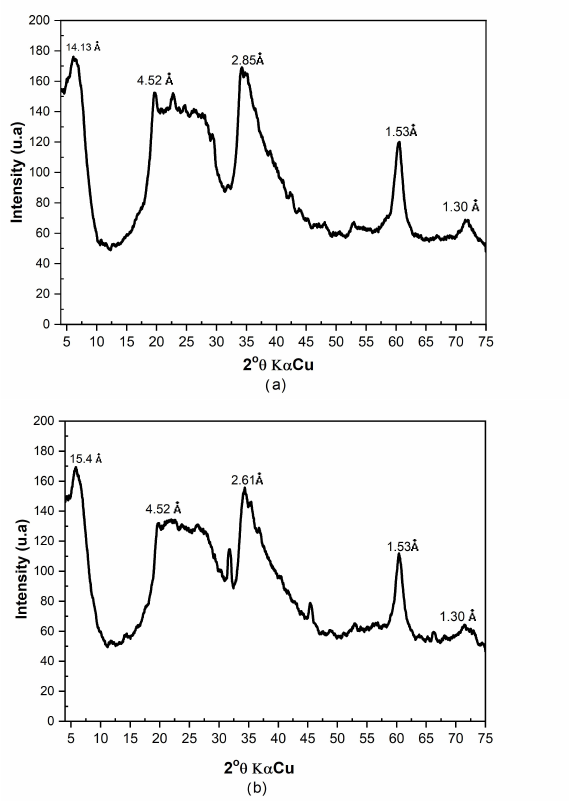
Figure 1. XRD curves of synthesized clays ( a ) NAS and ( b )HAS at 90